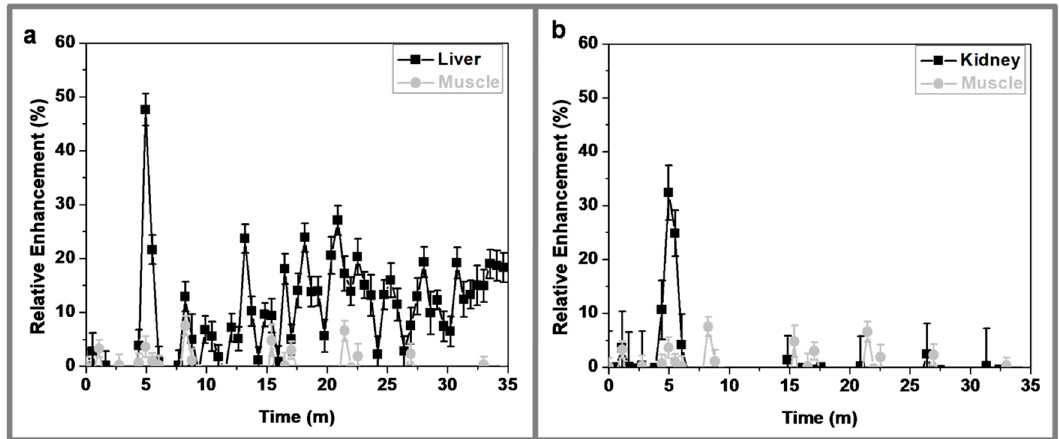
Figure 7. In vivo time courses of PEGylated CF@MF nanoparticles after intravenous injection in balb/c mice: ( a ) liver (black) and muscle (grey), ( b ) kidneys (black) and muscle (grey).